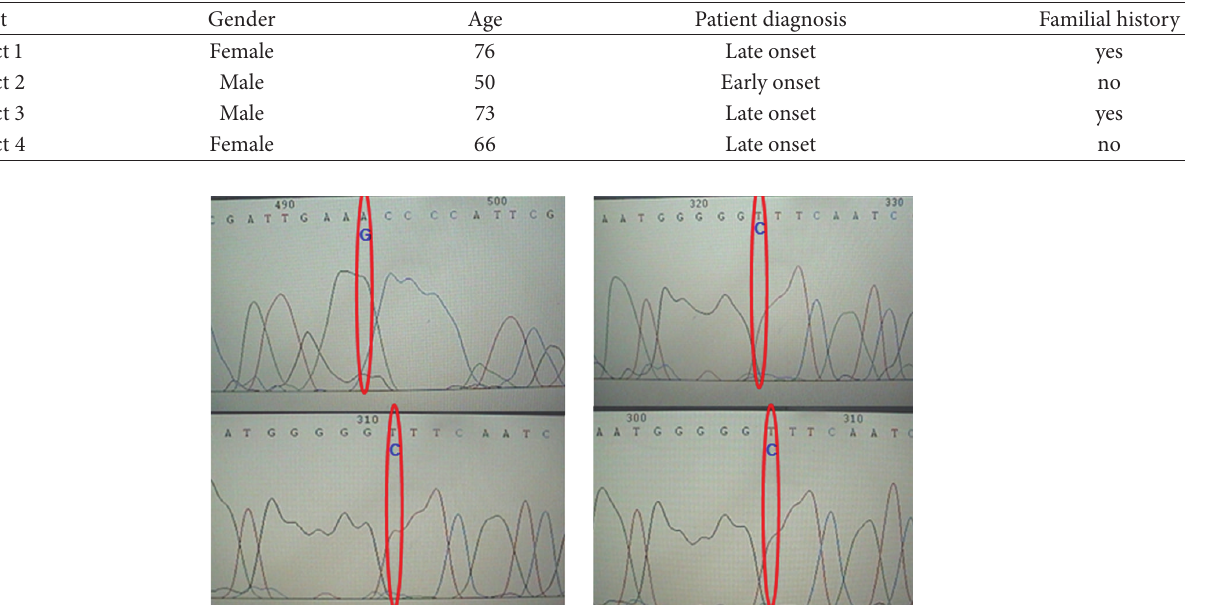
Figure 1: Sequencing histograms of the mitochondrial MTCO II gene . Representation of the sequencing in MTCO II gene. Variations are circled in red and nucleotide change is shown in blue.